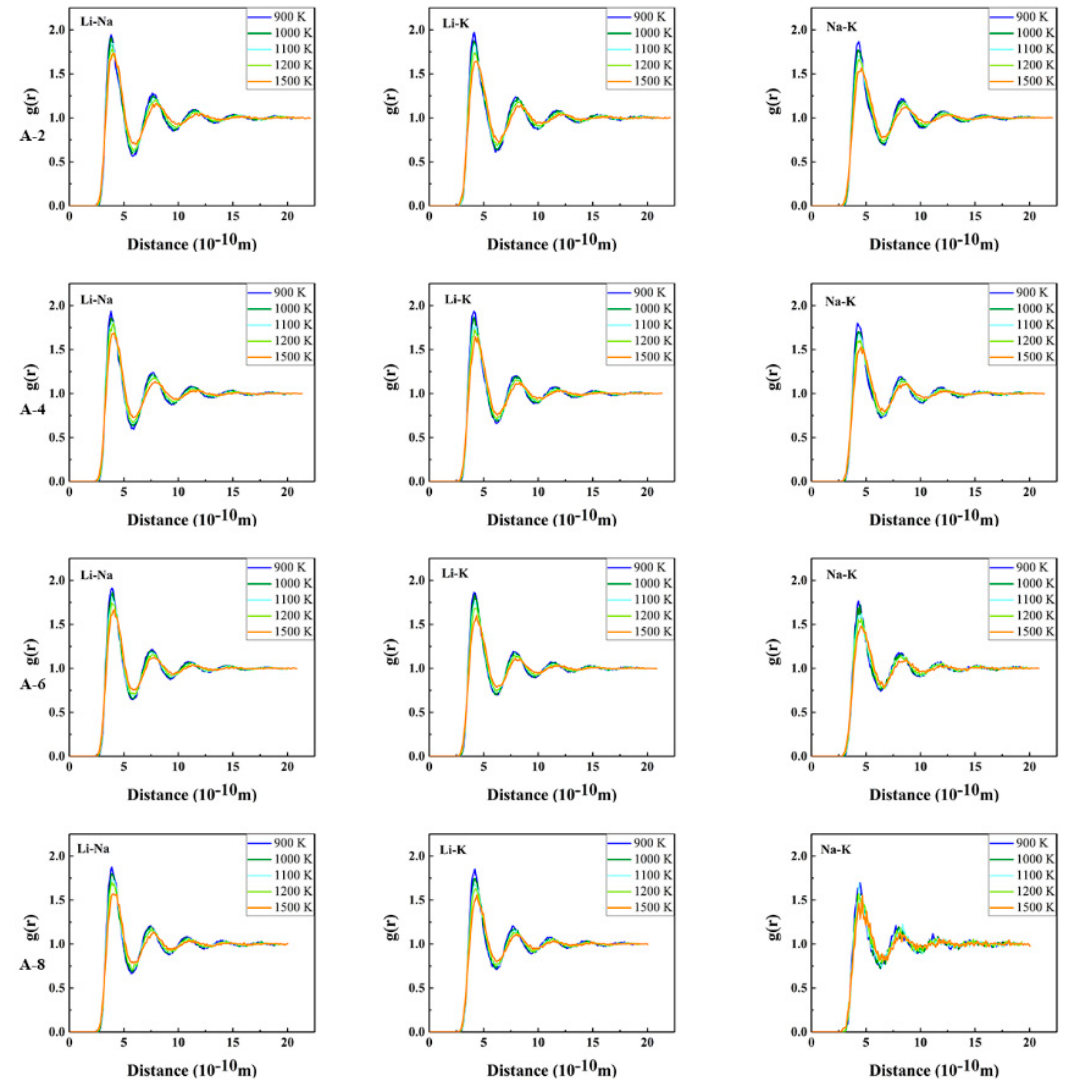
Figure A2. PDFs of unlike cation-cation pairs in the four ternary systems (A-2, A-4, A-6, and A-8) at 900 K, 1000 K, 1100 K, 1200 K, and 1500 K.